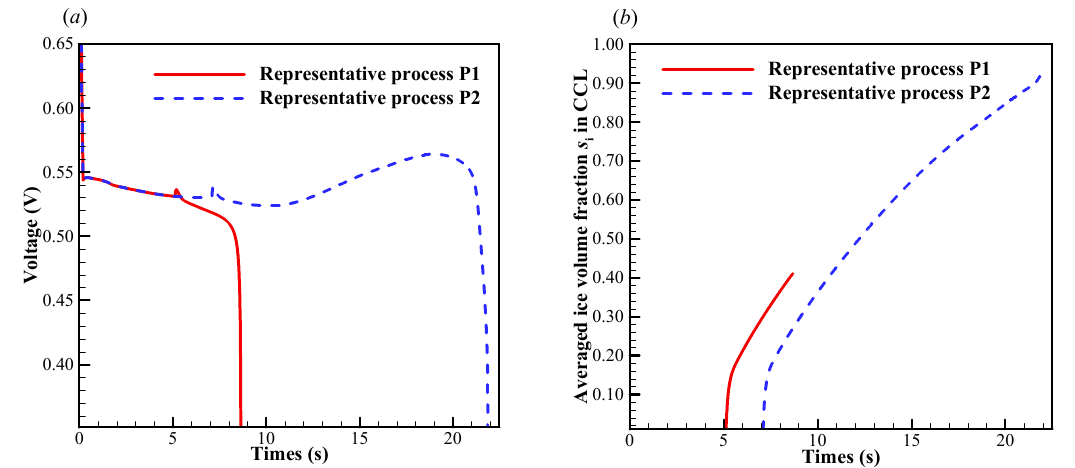
Figure 8. Evolution of ( a ) the cell voltage, and ( b ) the volume-averaged ice volume fraction in CCL. The cell starts from − 20 ◦ C with initial membrane water content λ 0 = 5.0 and current density I 0 = 0.30 A/cm 2 . The cell is supplied with dry hydrogen and oxygen. The stoichiometry ratio of the mass flow rate is 2.0 for both anode and cathode sides. The background pressure is 1.0 atm at both the anode and cathode outlets.